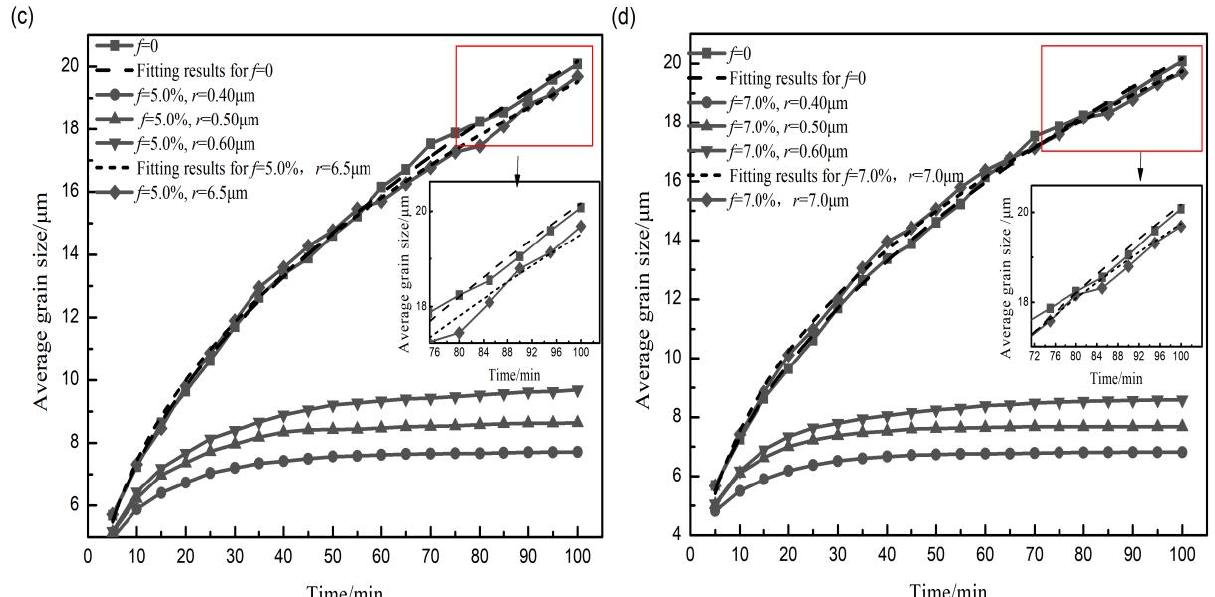
Figure 8. Average grain size as a function of time for SPP at the critical size: ( a ) f = 1%, ( b ) f = 3%, ( c ) f = 5%, and ( d ) f = 7%.